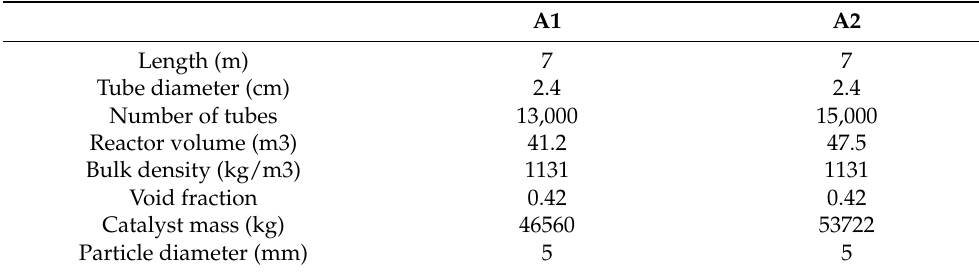
Table 6. Characteristics of the methanol synthesis reactors for each case